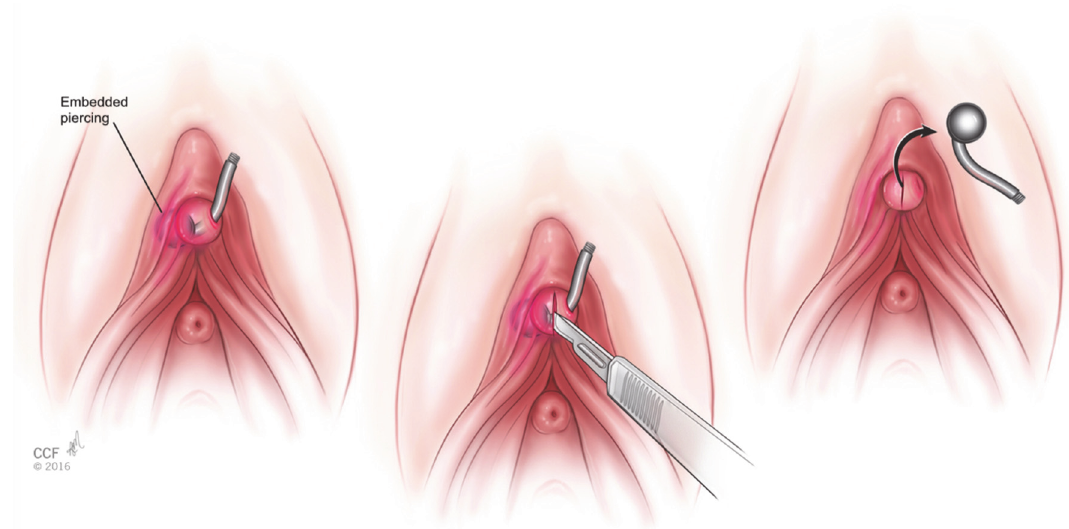
Figure 1: Illustration of removal of embedded clitoral glans piercing removed successfully with an outpatient